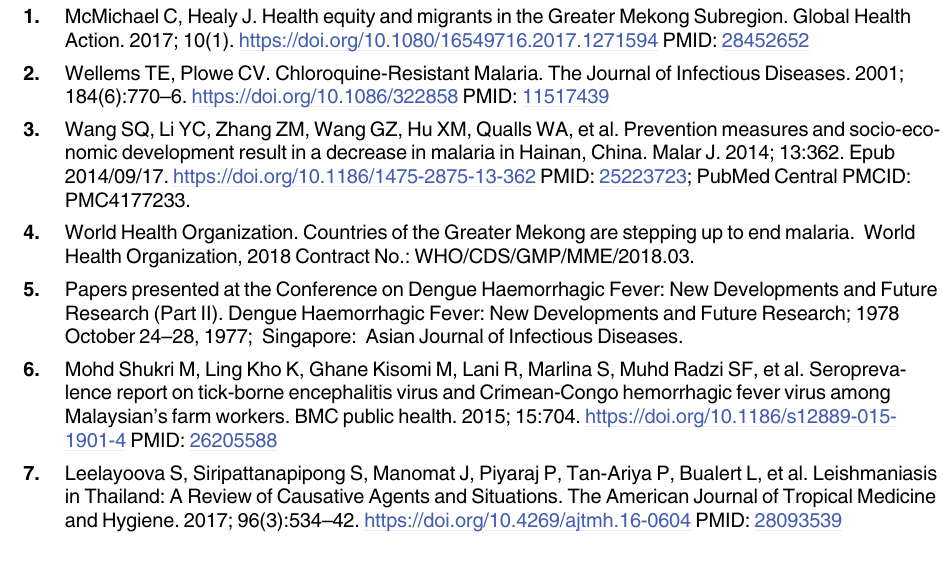
S2 Fig. Observational comparison of topics discussed in 2019 versus 1977. Specific topics (right) were formulated by reading through the notes collected, talk slides, and discussion points raised at the 2019 Phnom Penh meeting and additionally through careful read of the proceedings, papers and discussions of the 1977 Singapore meeting. Materials were again read carefully and the cumulative frequency of mentions (relative size of ribbons) for each discus- sion point tallied. Ribbon colors correspond to dengue (red), malaria (green), or general VBD (blue) discussion. Ribbon connections to the left panel describe the meeting (1977 and/or 2019) at which topics and disease were discussed. Relative frequency of each topic is propor- tional to the size of the grey boxes surrounding the topic